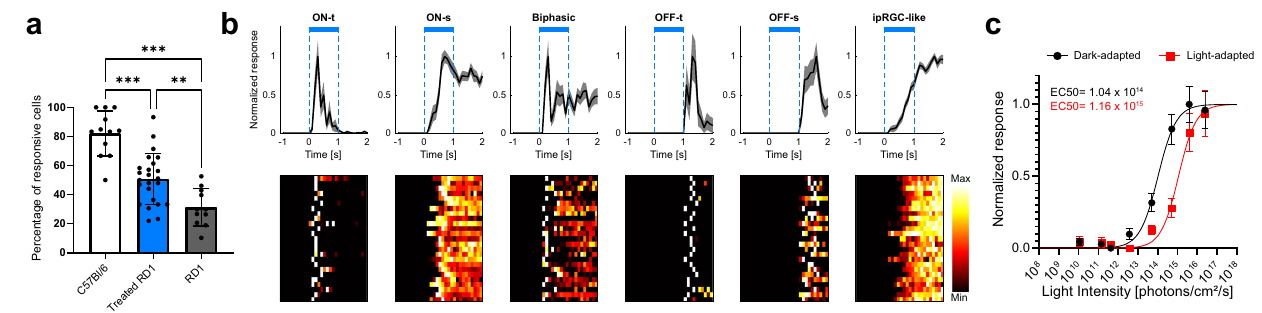
Fig. 6 Compound RGC responses in retinas from Mela(CTmGluR6)-treated rd1 mice determined on multi-electrode arrays. a We observed a signi fi cantly higher percentage of responsive cells in treated rd1 retinas ( n = 24) compared to untreated rd1 retinas ( n = 11, p = 0.005). There was also signi fi cant difference in percentage of responsive cells between C57BL/6 retinas ( n = 12) and Mela(CTmGluR6)-treated rd1 retinas ( p < 0.001). Data depicted as means± SD, dark points represent individual values of retinal explants. b Example average traces of different functional RGC categories. Light stimulation (470 nm, 5 × 10 14 photons/cm 2 /s, 1 s) indicated as blue bars. Below each representative average trace (mean ± s.e.m.) is a heat map of representative individual cells. c Normalized dark-adapted (black trace) and light-adapted (red trace) intensity response curves from RGCs of Mela(CTmGluR6)-treated rd1 retinas ( n = 62 cells) fi tted with a Hill curve (dark-adapted: slope = 0.9432, EC 50 = 1.04 × 10 14 photons/cm 2 /s; light- adapted: slope = 0.9794, EC 50 = 1.14 × 10 15 photons/cm 2 /s). Retinas were stimulated every 120 s with a blue light fl ash (470 nm, 500 ms, 1.12 × 10 10 – 2.5 × 10 16 photons/cm 2 /s), light adapted for 15 min (white light at 100 μ W cm − 2 ), and again stimulated with identical blue light fl ash protocol. Data shown as means ±